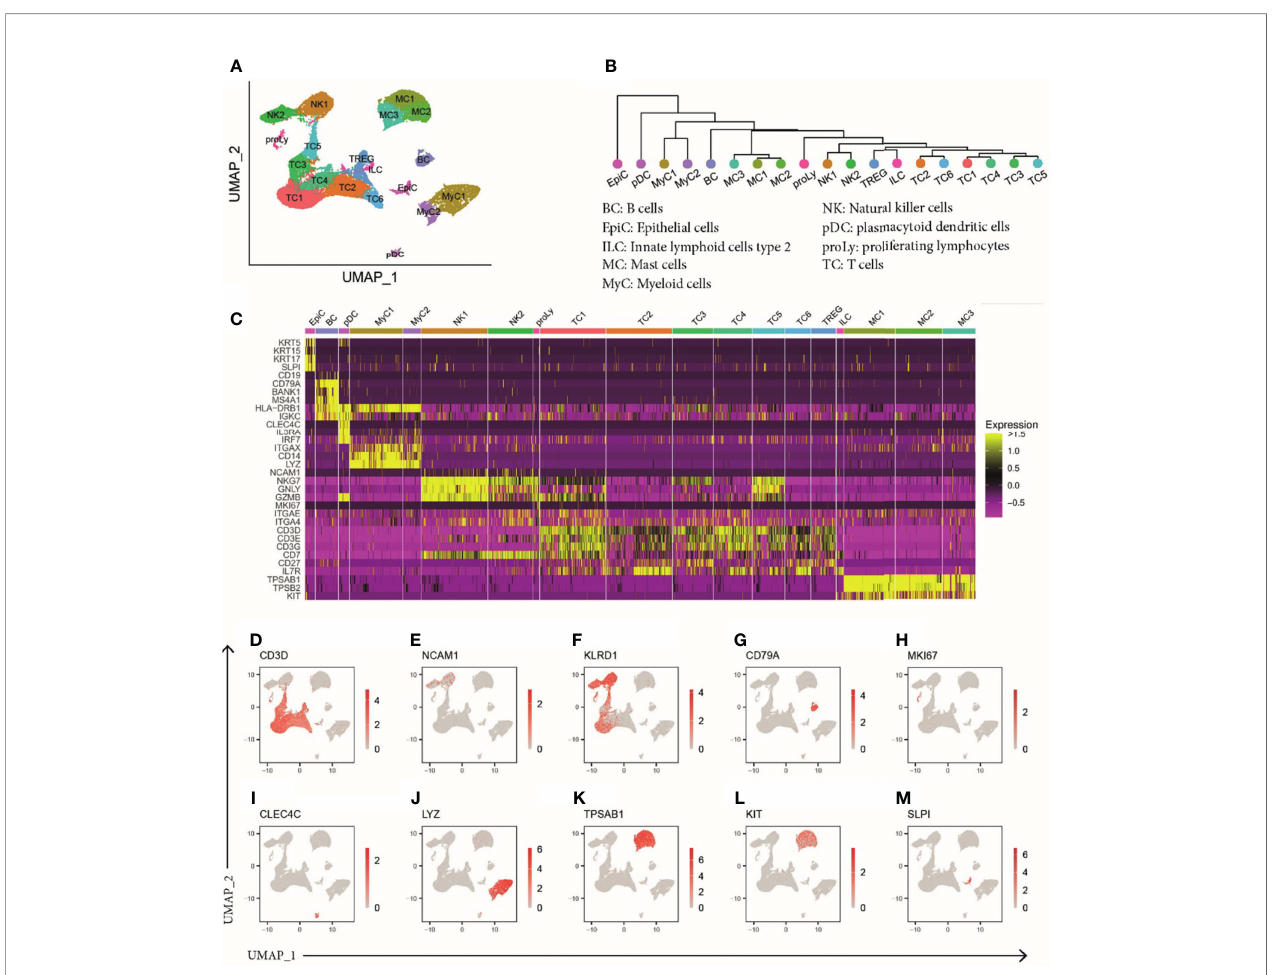
FIGURE 2 | ScRNA-seq analysis of human polyp cells of patients with CRSwNP or AERD. (A) UMAP of unsupervised clustering of 32,358 polyp cells integrated from 19 donors (CRSwNP n = 9 and AERD n = 10) showing 19 differently color-coded clusters. (B) Phylogenetic tree showing relatedness of cell clusters based on the distance between the average gene signatures of each cluster using average linkage. (C) Heat map displaying z-score of selected markers of group identity. (D – M) Feature plots combining all samples showing expression of cluster-speci fi c marker genes as overlaid onto UMAP plots. Red color displays intensity levels of natural log-transformed gene expression. UMAP, Uniform Manifold Approximation and Projection; scRNA-seq, single-cell RNA sequencing; CRSwNP, chronic rhinosinusitis with nasal polyps; AERD, aspirin-exacerbated respiratory